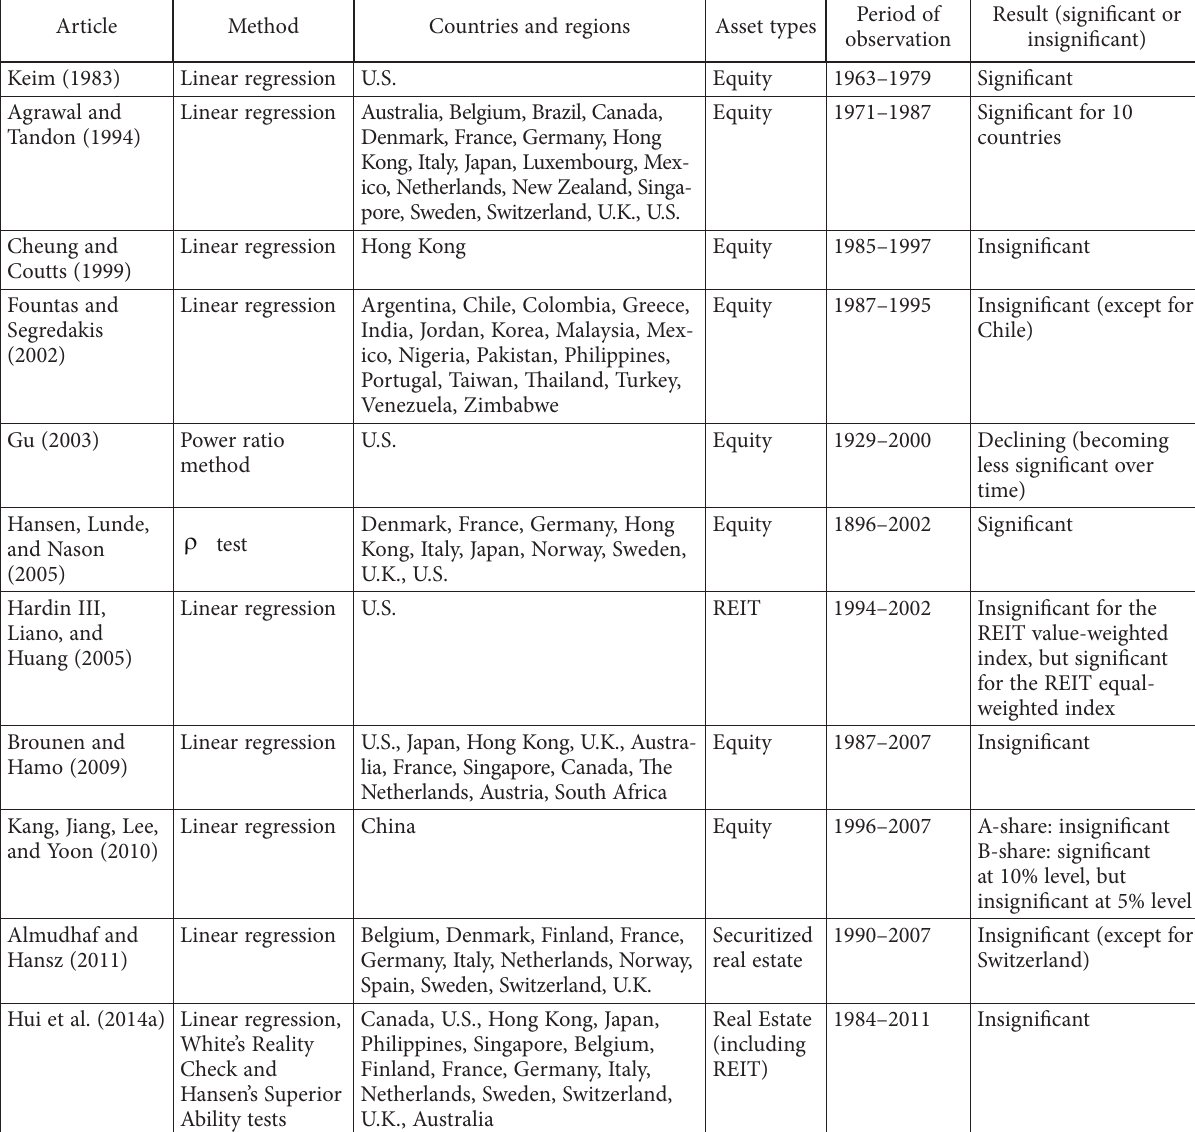
Table 2. Results of previous works on January Effect (source: Hui & Chan, 2015,